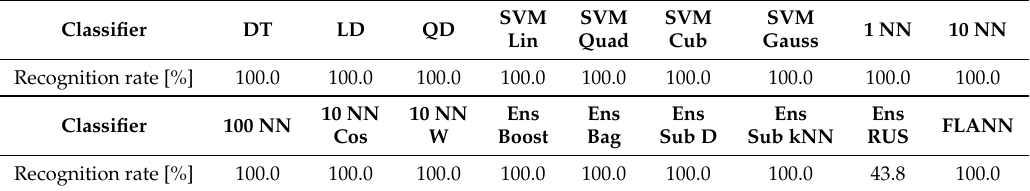
Table 5. 10-fold cross-validation results for dataset 1, configuration (ii).